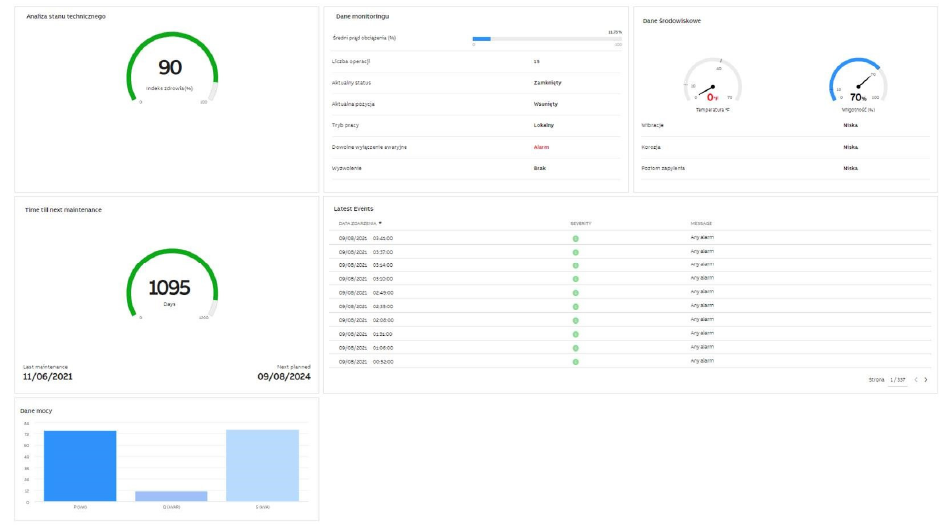
Figure 12. Equipment maintenance prediction.